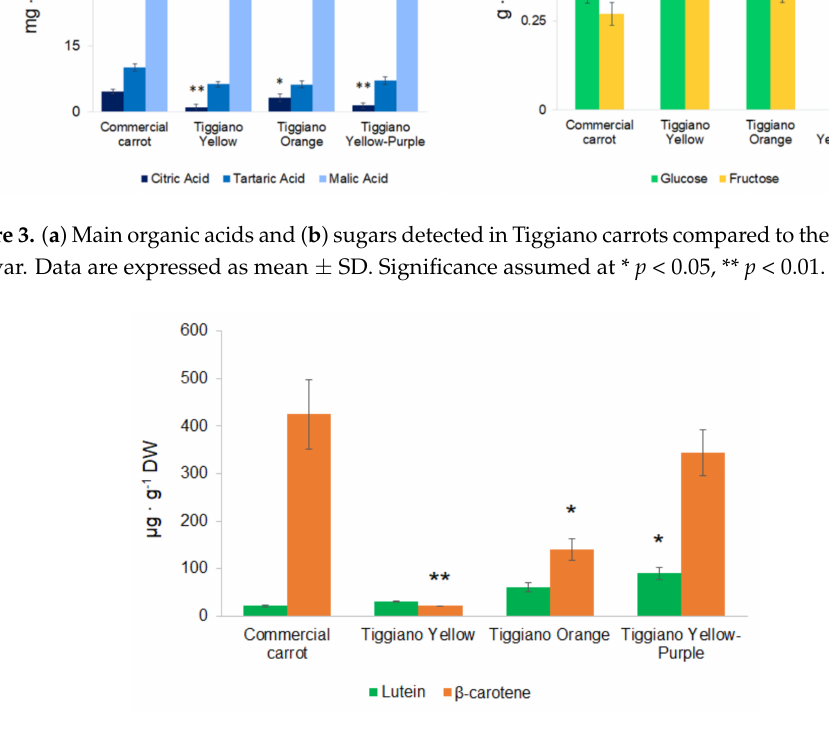
Figure 4. Carotenoid content in Tiggiano carrots compared to a commercial cultivar. Significance assumed at * p < 0.05, ** p < 0.01.